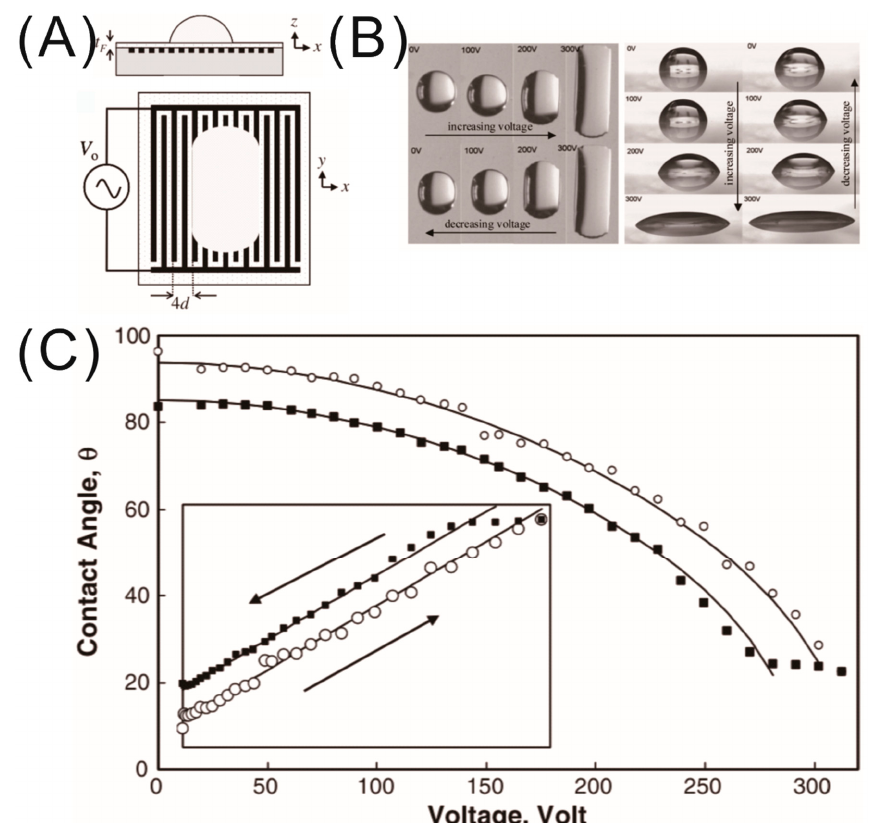
Figure 4. ( A ) Schematic of diletcrowetting experiment (ambient air) depicting the cross-sectional view of a dielectric droplet sitting on a substrate without voltage, and the top view of a spreading droplet on linear interdigitated electrodes (IDEs). ( B ) Optical images of the top and side views of a spreading droplet under different dielectrowetting voltages. ( C ) Apparent contact angle of a stripe-shaped droplet of propylene glycol as a function of applied voltage. Open circles represent the increasing voltage half cycle, and filled squares represent the decreasing voltage half cycle. Inset: linear fit to the cosine of the apparent contact angle versus applied voltage squared. Images are reproduced from Reference [21] with the permission of the American Physical Society.